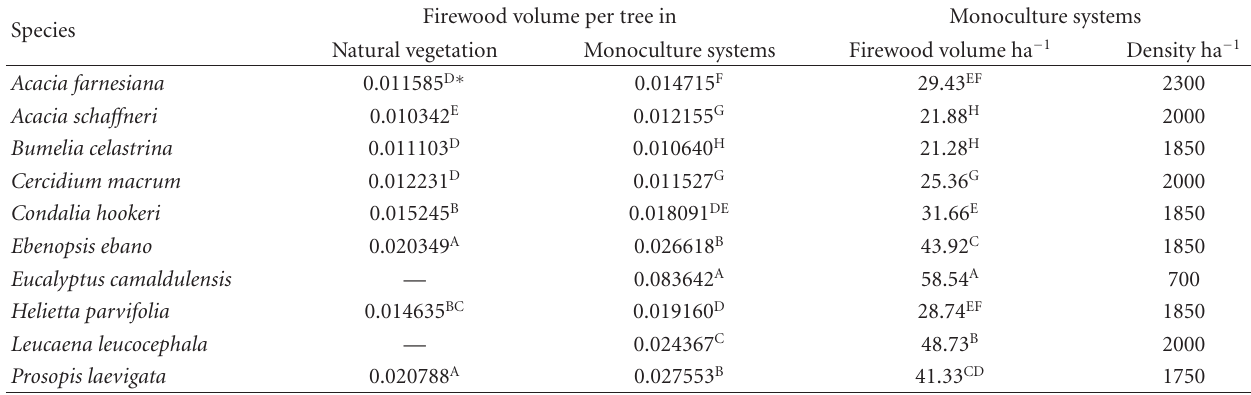
Table 3: Comparison between wood volume production (m 3 tree − 1 ) of ten wood species in the natural vegetation and monoculture systems in a semiarid region of